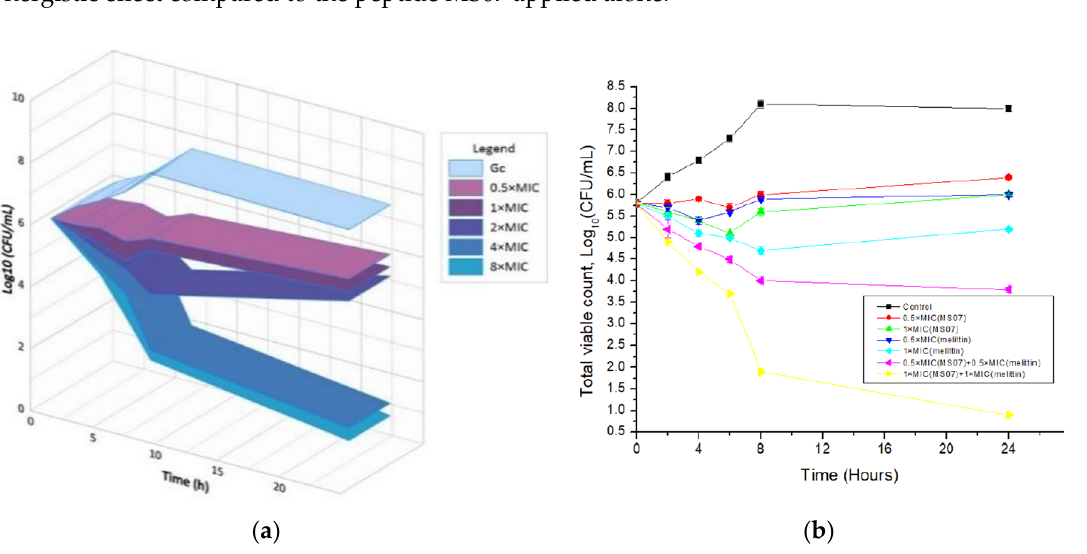
Figure 5. ( a ) Killing kinetics of MS07 with different MIC concentrations against Escherichia coli compared with the growth control (GC) for 24 h. ( b ) The synergistic effect of MS07 with melittin improved the killing kinetics against Escherichia coli for 24 h compared to it acting